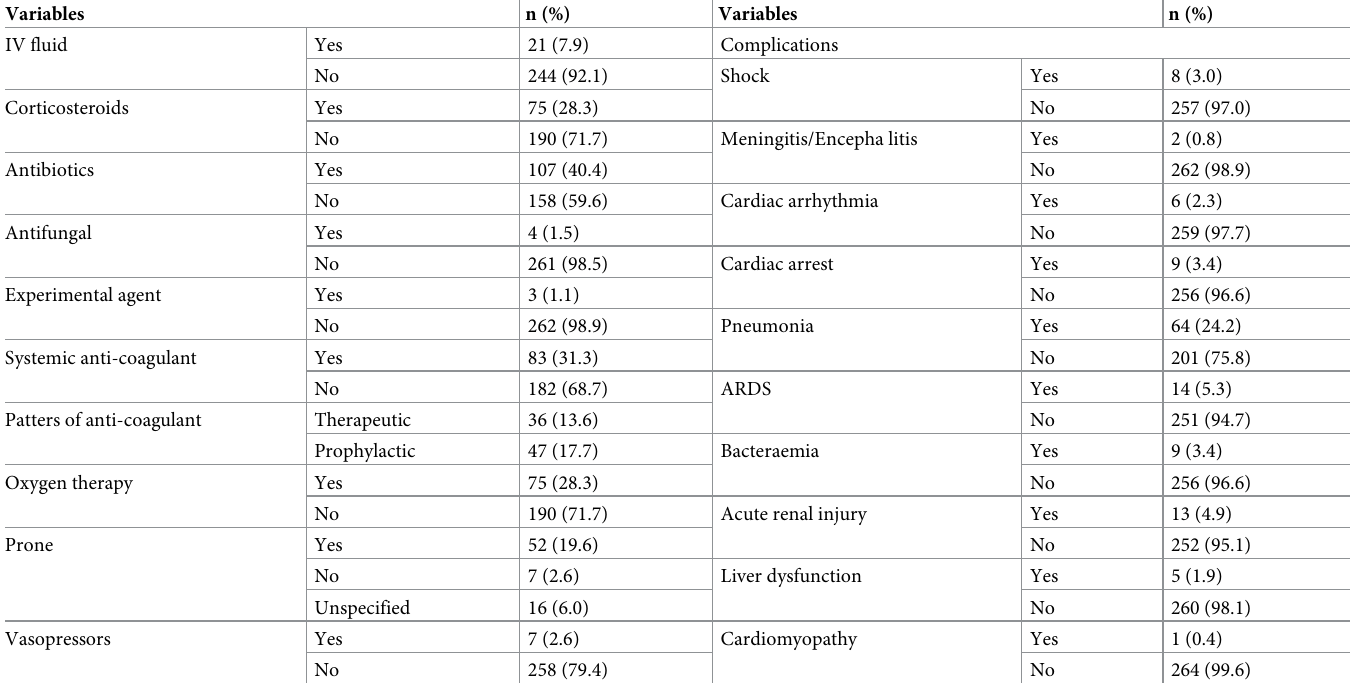
Table 5. Treatment and complications of study participants.